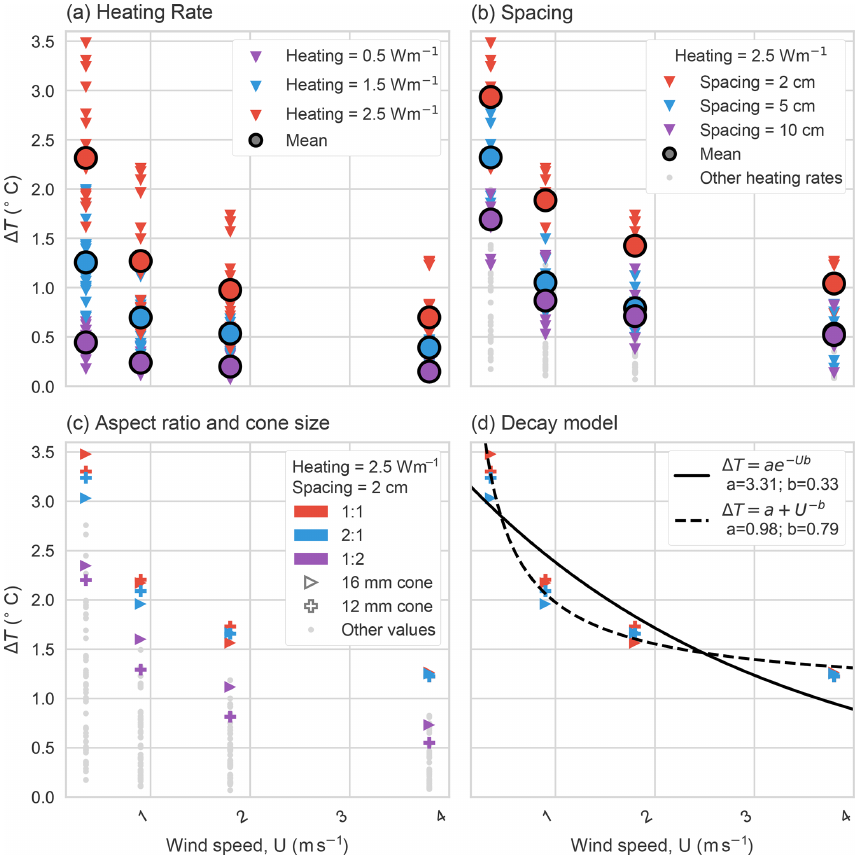
Figure 3. The (cid:49)T for all combinations of cones and heating rates (see Table 1). The data are stratified using the variable with the largest impact, i.e., temperature difference between coned cable sections pointing in different directions. (a) All temperature differences as a function of wind speed classified by heating rate. (b) The highest heating rate is selected (red points in a ) and data are classified according to the spacing between cones. Data with lower heating rates are shown in grey. (c) The 2cm spacing and highest heating rates (red points in a and b ) are selected and then classified according to the cone aspect ratio. The 12mm cones are marked with pluses, and the 16mm cones are marked with right-pointing triangles. All other heating rates and cone spacings are shown in grey. (d) The best performing parameters are fit with an exponential and power law model (see Sect. 2.1 for